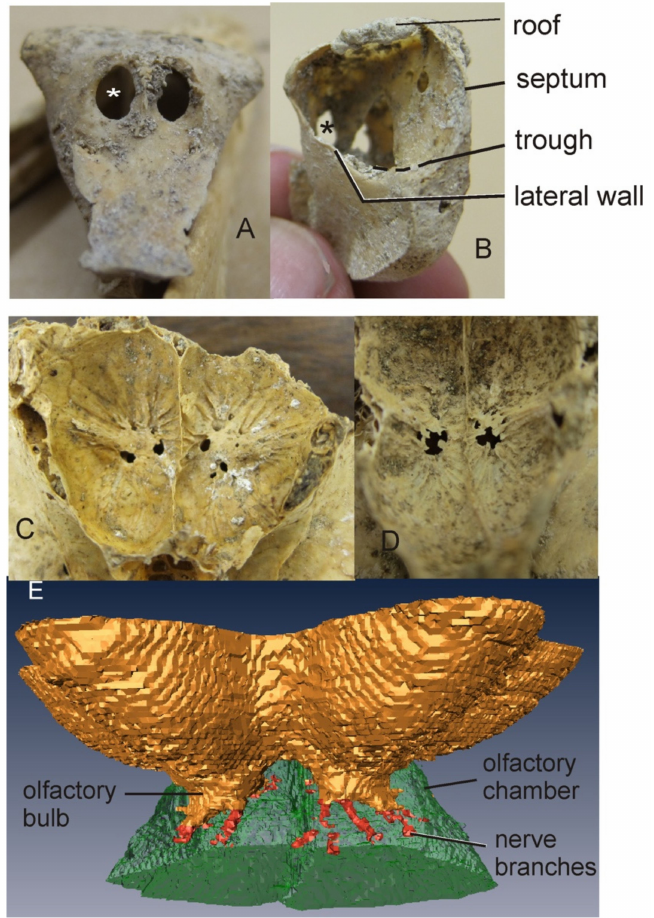
Figure 2. Moa olfactory foramina. ( A ) juvenile Anomalopteryx didiformis , ethmoid ossification, caudal view. ( B ) right rostrolateral view. * marks the foramen ( C ) A. didiformis , rostral view of foramina with radiating nerve grooves; ( D ) Dinornis novaezealandiae , same view. ( E ) Dinornis robustus , reconstruction of interface brain-olfactory chamber dorsal